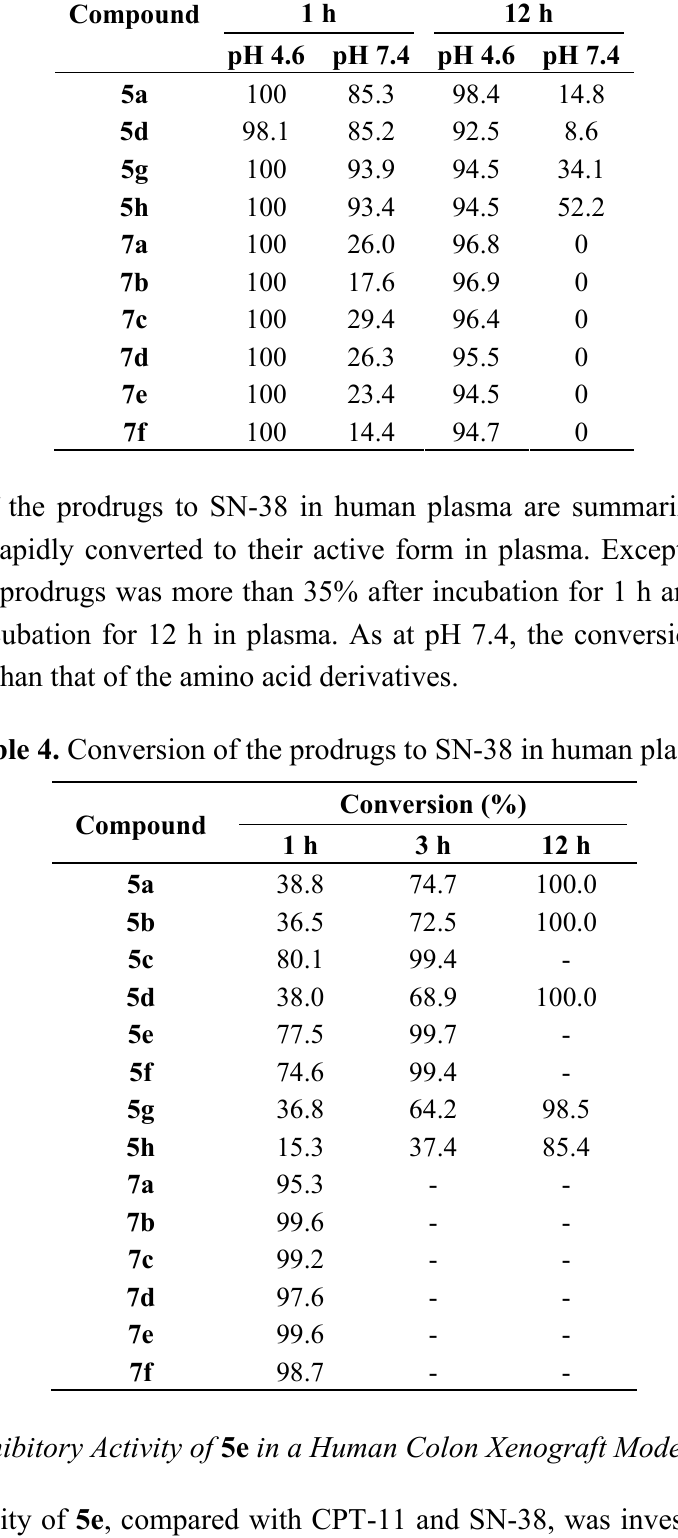
Table 3. The chemical stability of the prodrugs in pH 4.6 and pH 7.4 conditions. Compound